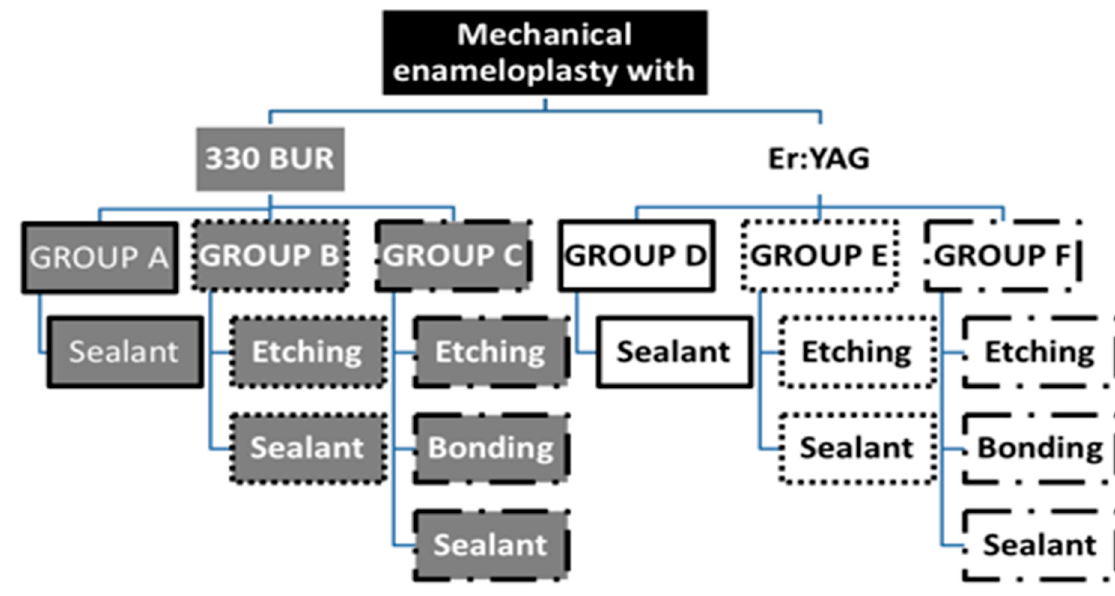
Figure 1. Group design. The preparations for the 6 groups (A–F). For groups A–C, 330 tungsten bur was used and Er:YAG laser for groups D–F.